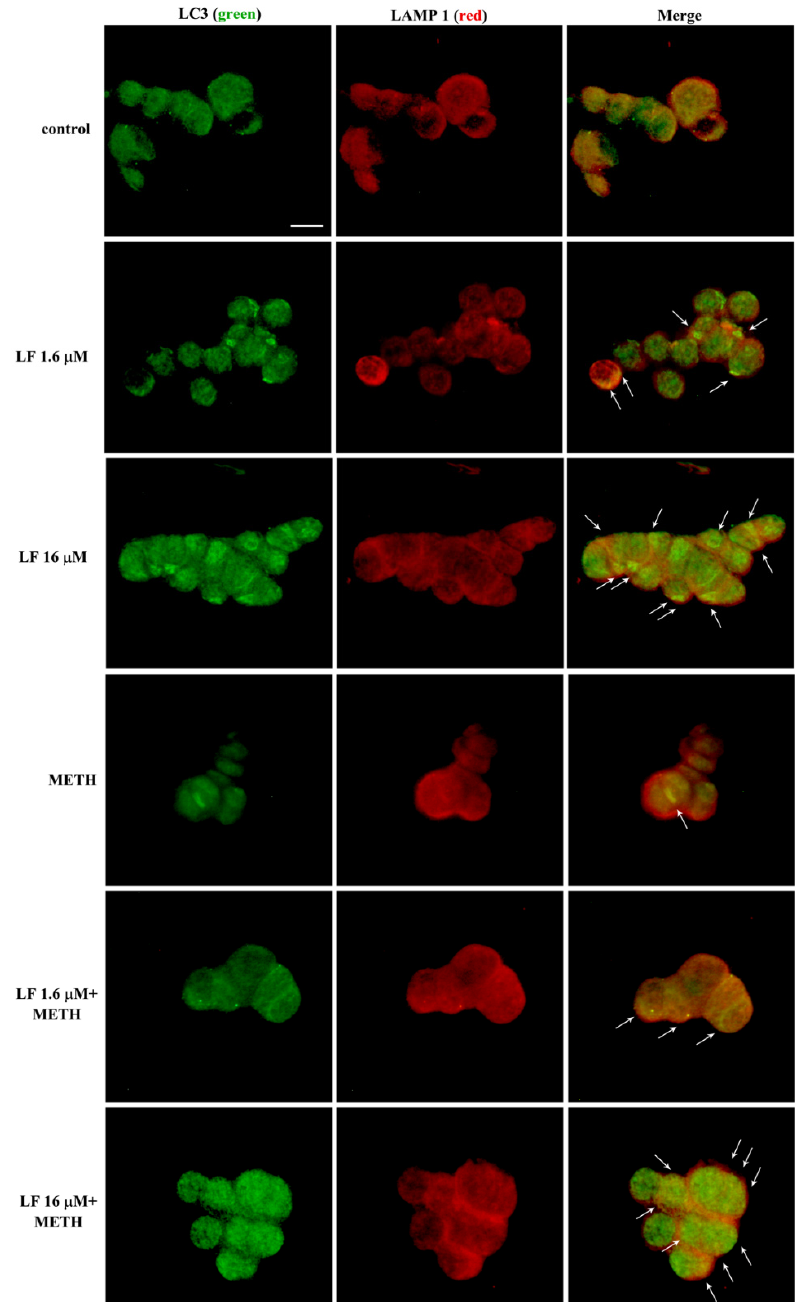
Figure 14. LF increases LC3 and LAMP1 co-localization. Representative double immuno-fluorescence for LC3 (green) and LAMP1 (red), and their merge in combined LF and METH treated cells. Arrows indicate cells with intensely merged fluorescence, resulting in yellow puncta. Scale bar = 12 μ M.